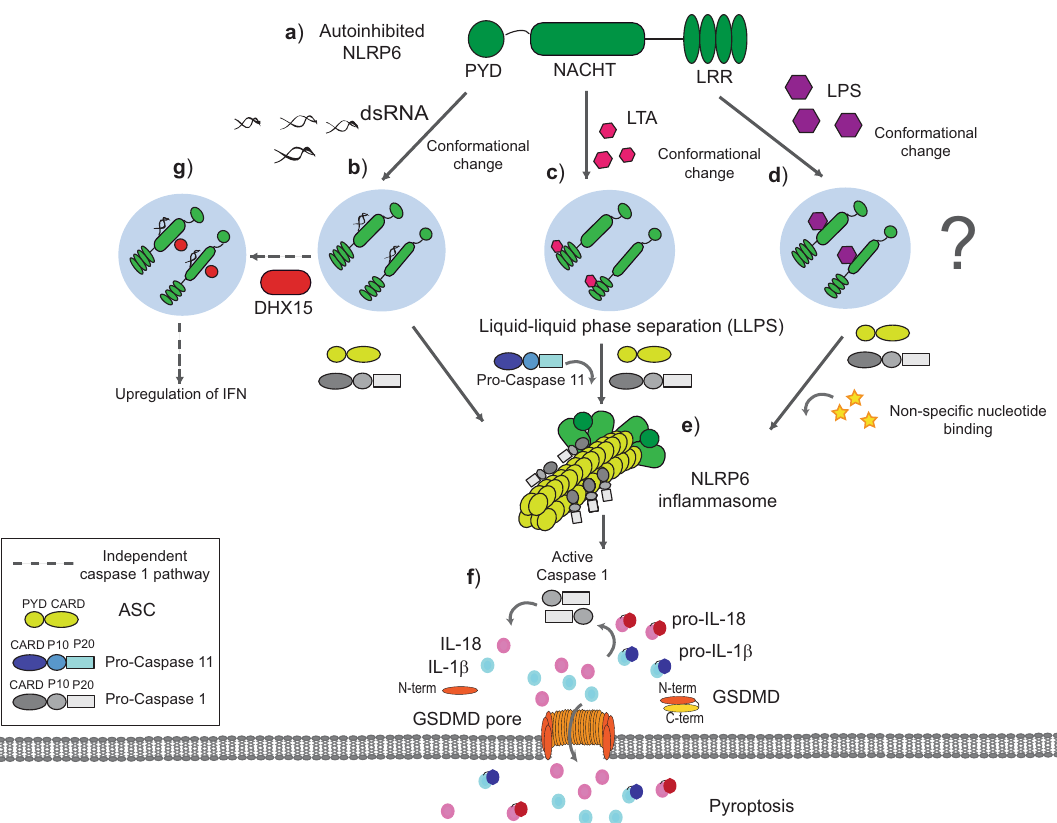
Fig. 1 New insights into NLRP6 in fl ammasome formation. a The NLRP6 protein is autoinhibited in basal conditions. b , c dsRNA, LTA can bind directly to NLRP6, thus causing a possible conformational change to help LLPS as an early step necessary for in fl ammasome formation. d LPS can bind directly to NLRP6, which probably leads to the formation of LLPS, although this is not known; in vitro recombinant NLRP6 protein requires ATP after LPS binding to form an oligomer. e If ASC binds to NLRP6 oligomer, it induces a solid particle of in fl ammasome f that activates caspase-1 and/or caspase-11, which in turn processes GSDMD and results in plasma membrane pore formation and the release of pro-in fl ammatory cytokines and intracellular content. g If the NLRP6 in fl ammasome is not formed by interaction with ASC, NLRP6 in LLPS induces an alternative in fl ammasome-independent pathway by inducing interferon and interferon-stimulated genes 43